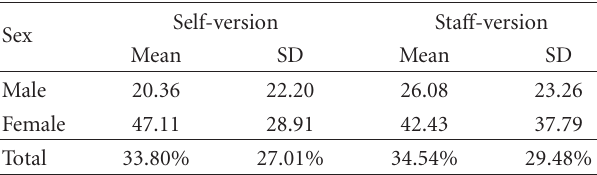
Table 2: Mean and SD of NHHI results in both groups (male/